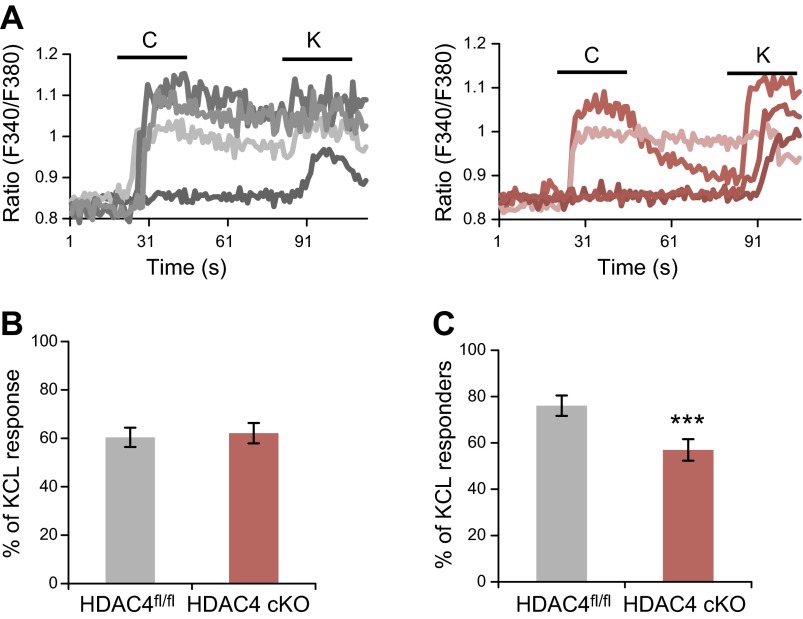
HDAC4 gene transcription and capsaicin sensitivity in vitro.
A) Representative fluorescence traces from calcium imaging experiments. C = 100 nM capsaicin; K = 50 mM KCl. HDAC4fl/fl left, HDAC4Nav1.8 cKO right. B) Mean peak capsaicin response was plotted as a percentage of the maximum response to KCl. C) Cells were considered capsaicin responsive if the capsaicin peak was >20% of the KCl peak. Significantly fewer HDAC4Nav1.8 cKO neurons responded to capsaicin treatment (n = 5–6). ***P < 0.001; Fisher’s exact test.